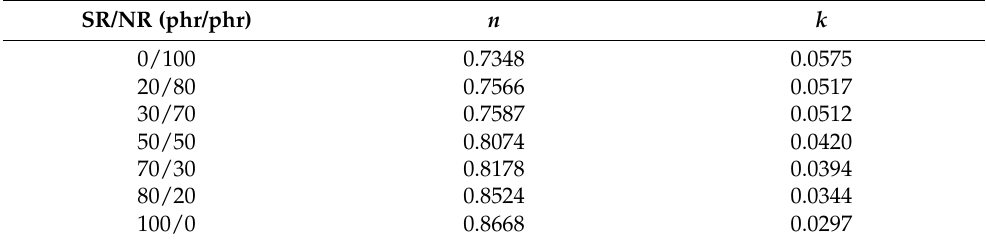
Figure 11. Fitted sorption curves of SR/NR blends. Table 4. The values of n and k of SR/NR blends.